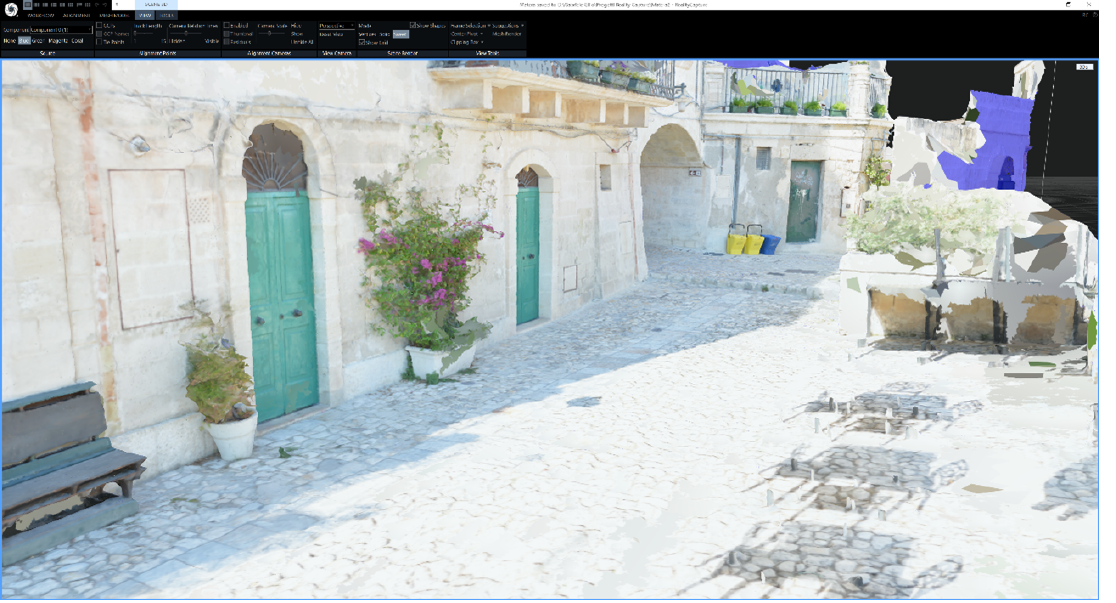
Figure 4. RealityCapture user interface showing the reconstructed mesh with the texture